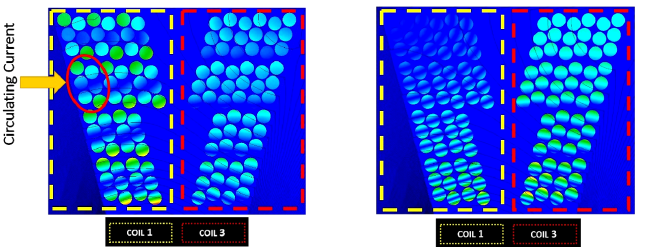
Figure 15. Comparison of current density (J) in the strands for the 24 parallel strands models (ARR2) at time instant (0.00194s): ( Left ) with circulating current; ( Right ) without circulating